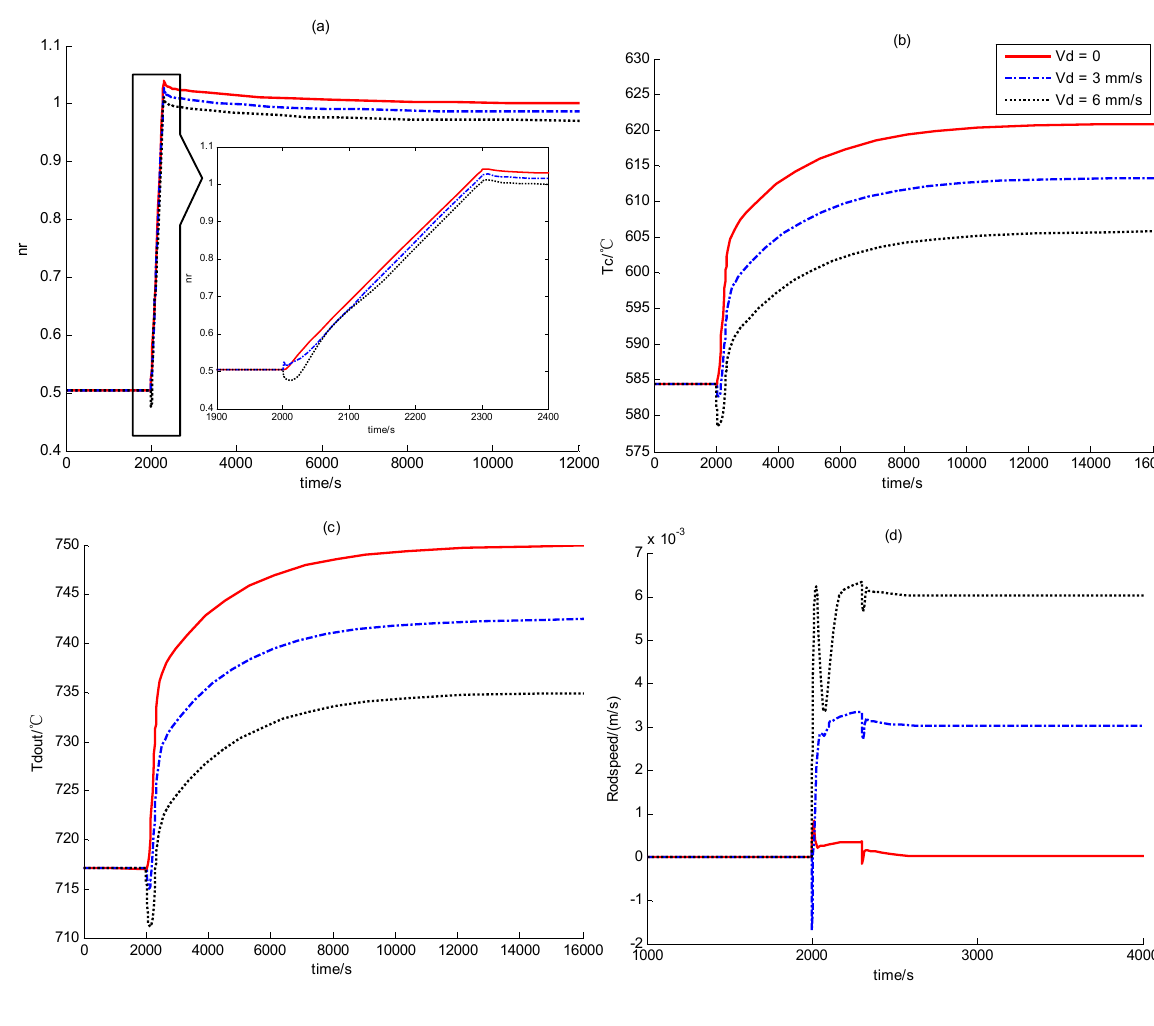
Figure 6. Power lift controlled by proportional PLC. ( a ) Relative nuclear power-level; ( b ) Average temperature of fuel elements; ( c ) Outlet helium temperature of the reactor; ( d ) Control rod speed